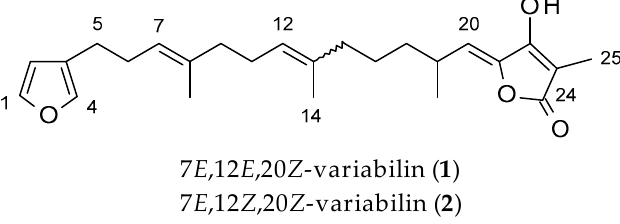
Figure 1. Structure of a mixture of 7 E ,12 E ,20 Z -variabilin ( 1 ) and 7 E ,12 Z ,20 Z -variabilin ( 2 ).